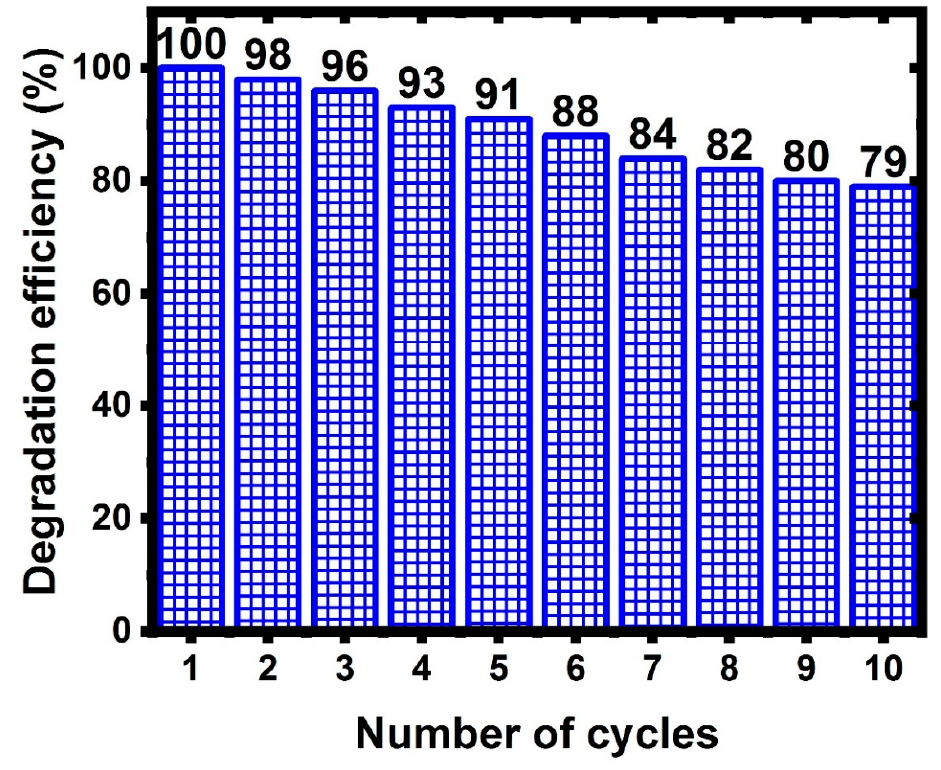
Figure 10. 10 Cyclic time for using Ag NPs/CNT (2) nanocomposite for photocatalytic degradation.